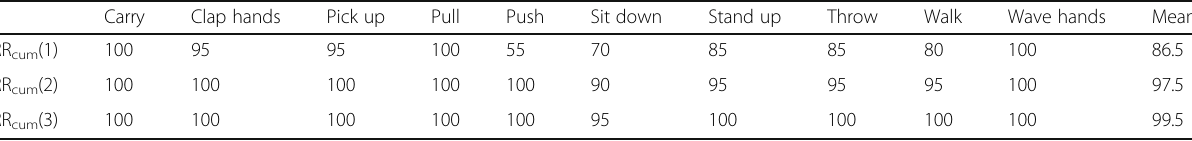
Table 8 Cumulative recognition rates for UTKinect Human Detection dataset Carry